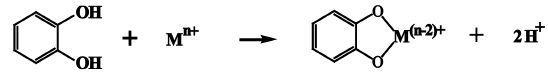
Figure 34. Adsorption of some metal ions from a HEPES buffer solution by crosslinked persimmon gel at different equilibrium pH values. Initial concentration of each metal = 0.5 mM, weight of gel = 10 mg, test solution volume = 10 mL, shaking time = 24 h.